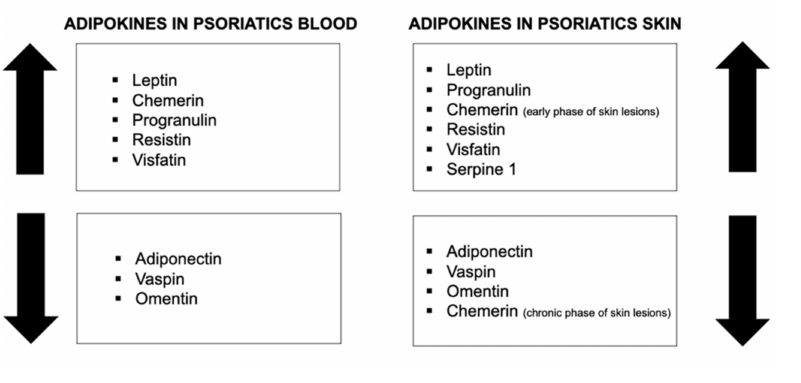
Figure 2. Adipokines in psoriatic patients’ skin and blood. = increased level; = decreased level.